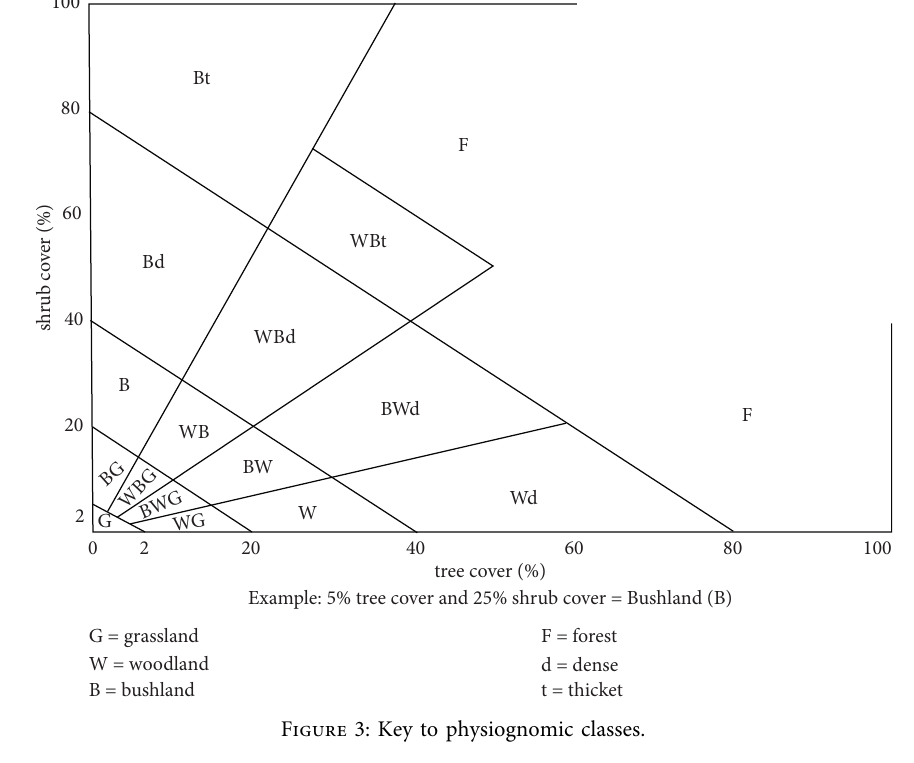
Figure 3: Key to physiognomic classes.